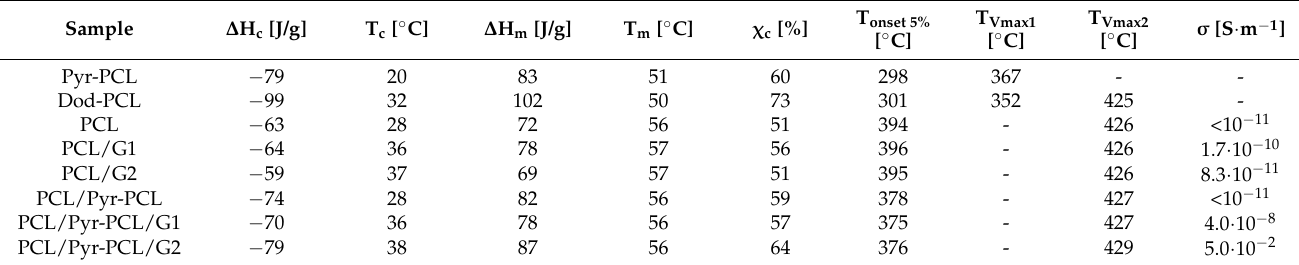
Figure 3. DSC thermograms of linear PCL, second heating ( a ) and cooling ( b ): (1) Pyr-PCL, (2) Dod-PCL, (3) PCL. Table 1. DSC, TGA and surface conductivity measurement